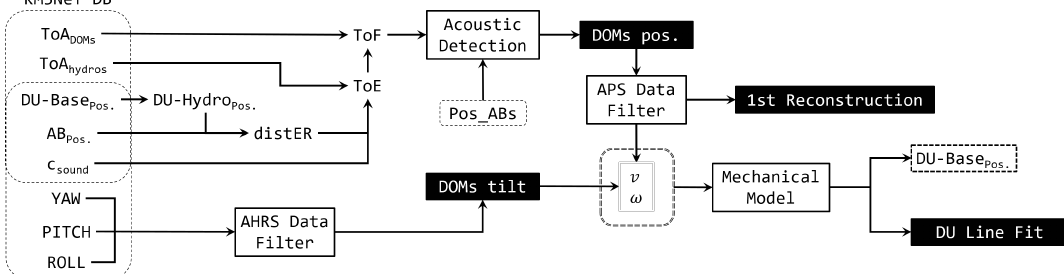
Figure 7. DU Line Fit block diagram. This scheme shows the steps in the implementation of the DU Line Fit in KM3NeT